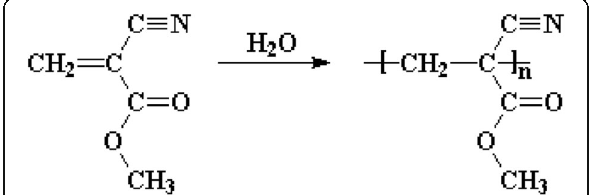
Fig. 3 Polymerization of Ethyl Cyanoacrylate in the presence of water (weak